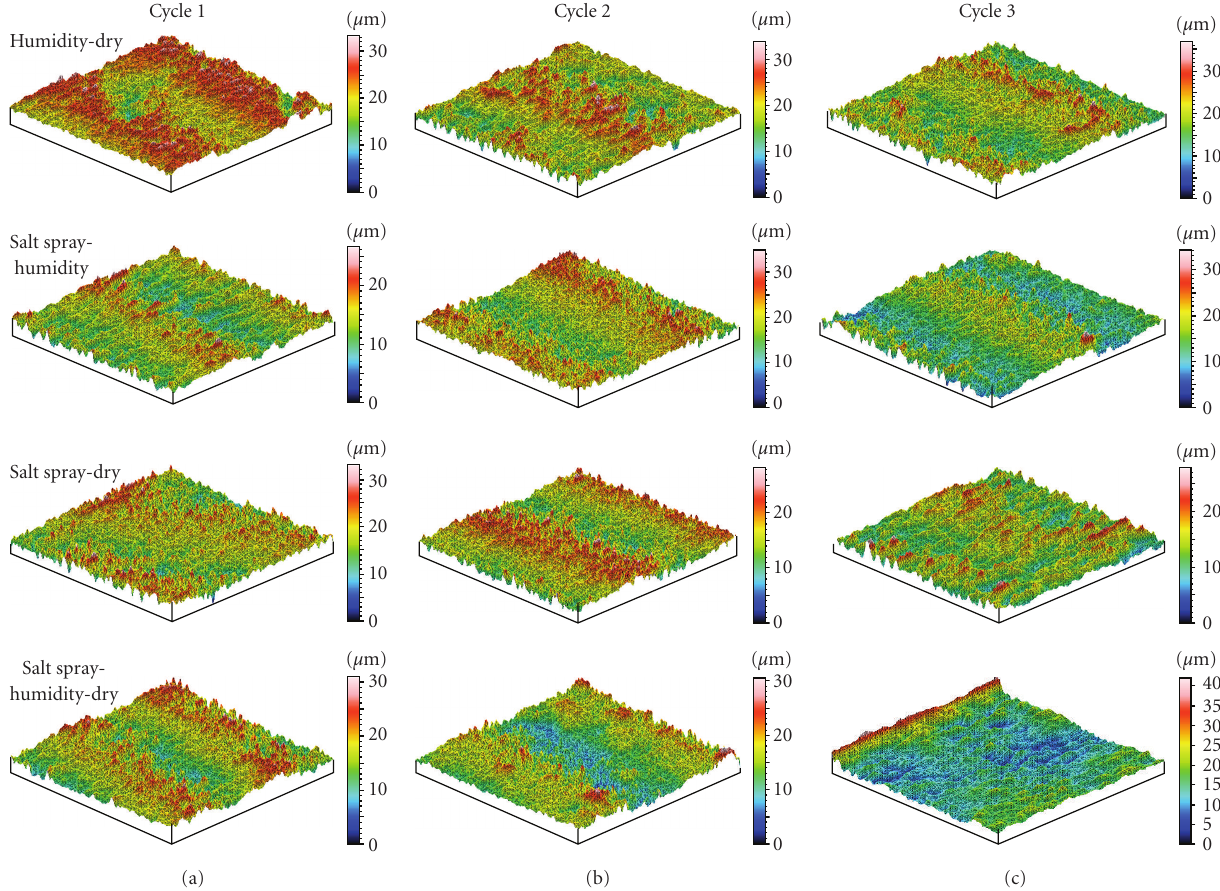
Figure 7: 3D Laser profilometry of the AE44 coupons arranged by test condition based on cycle number. The blue colors correspond to the lowest surface values, while the pink colors represent the highest surface values. Notice the increasing amount of intergranular corrosion following each cycle, as denoted by an increase in the connecting blue areas and a decrease in the red